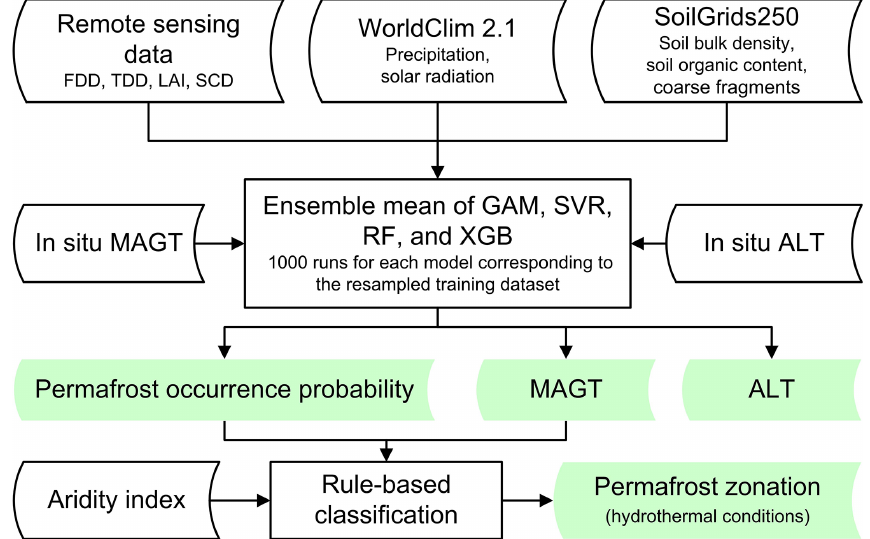
Figure 1. The data processing workflow used to compile the permafrost datasets (FDD, freezing degree days; TDD, thawing degree days; LAI, leaf area index; SCD, snow cover duration; MAGT, mean annual ground temperature; ALT, active layer thickness; GAM, generalized additive model; SVR, support vector regression; RF, random forest; and XGB, extreme gradient